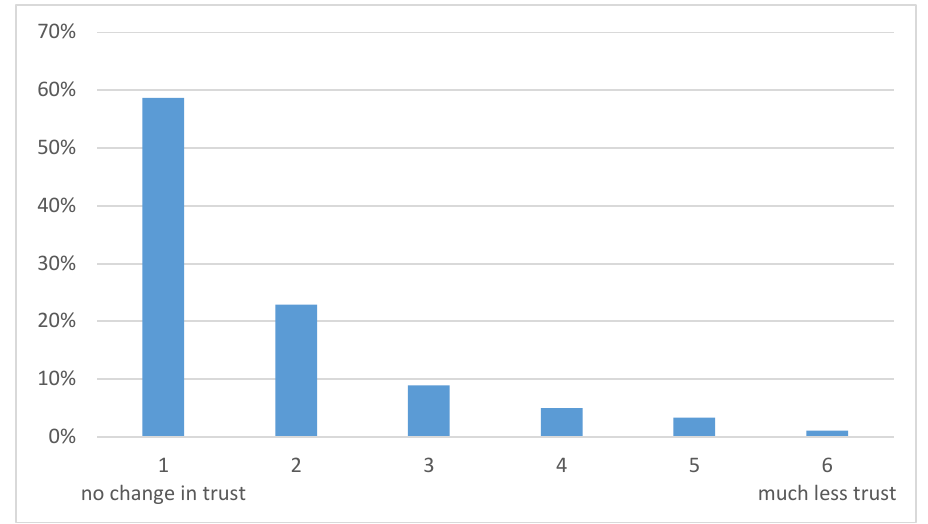
Figure 3. Effect of automation surprise on trust in automation (N = 180). 106 respondents (59%) reported that their trust had not changed following the AS event. Only 17 respondents (9%) reported a reduction in trust of score 4 or higher (i.e., over the halfway mark).